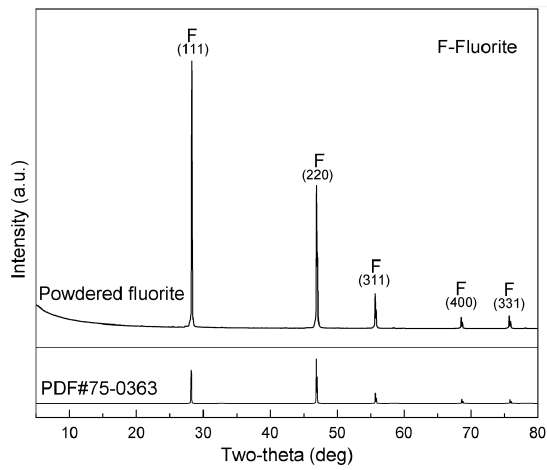
Figure 1. XRD pattern of powered fluorite.